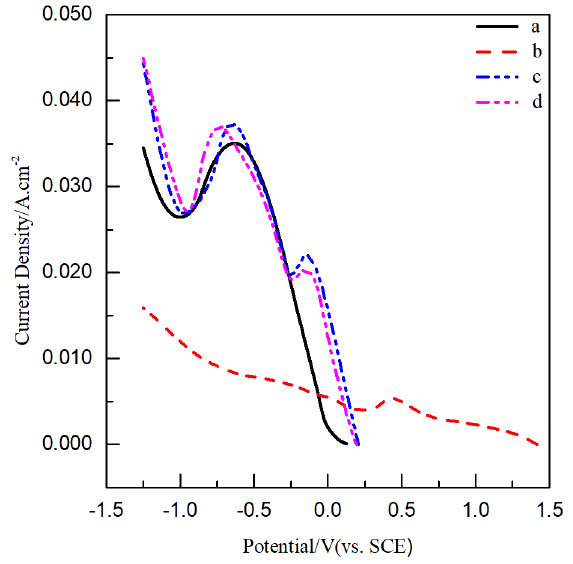
Figure 5. LSV curves obtained in different solutions. Curve a in solution 1 without PEG; curve b in solution 3 without PEG; curve c in solution 5 without PEG; and curve d in solution 6 with 4 μ M PEG. Scan rate: 200 mV/s.